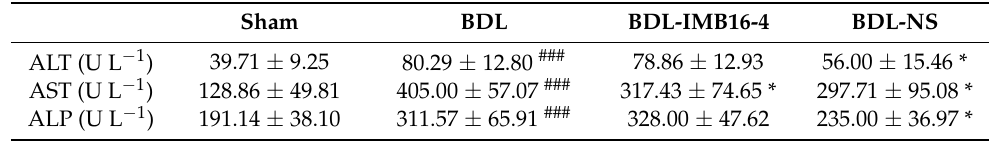
Table 4. Serum biochemical markers of bile duct ligated (BDL)-treated rats, Mean ± SD, n = 7.